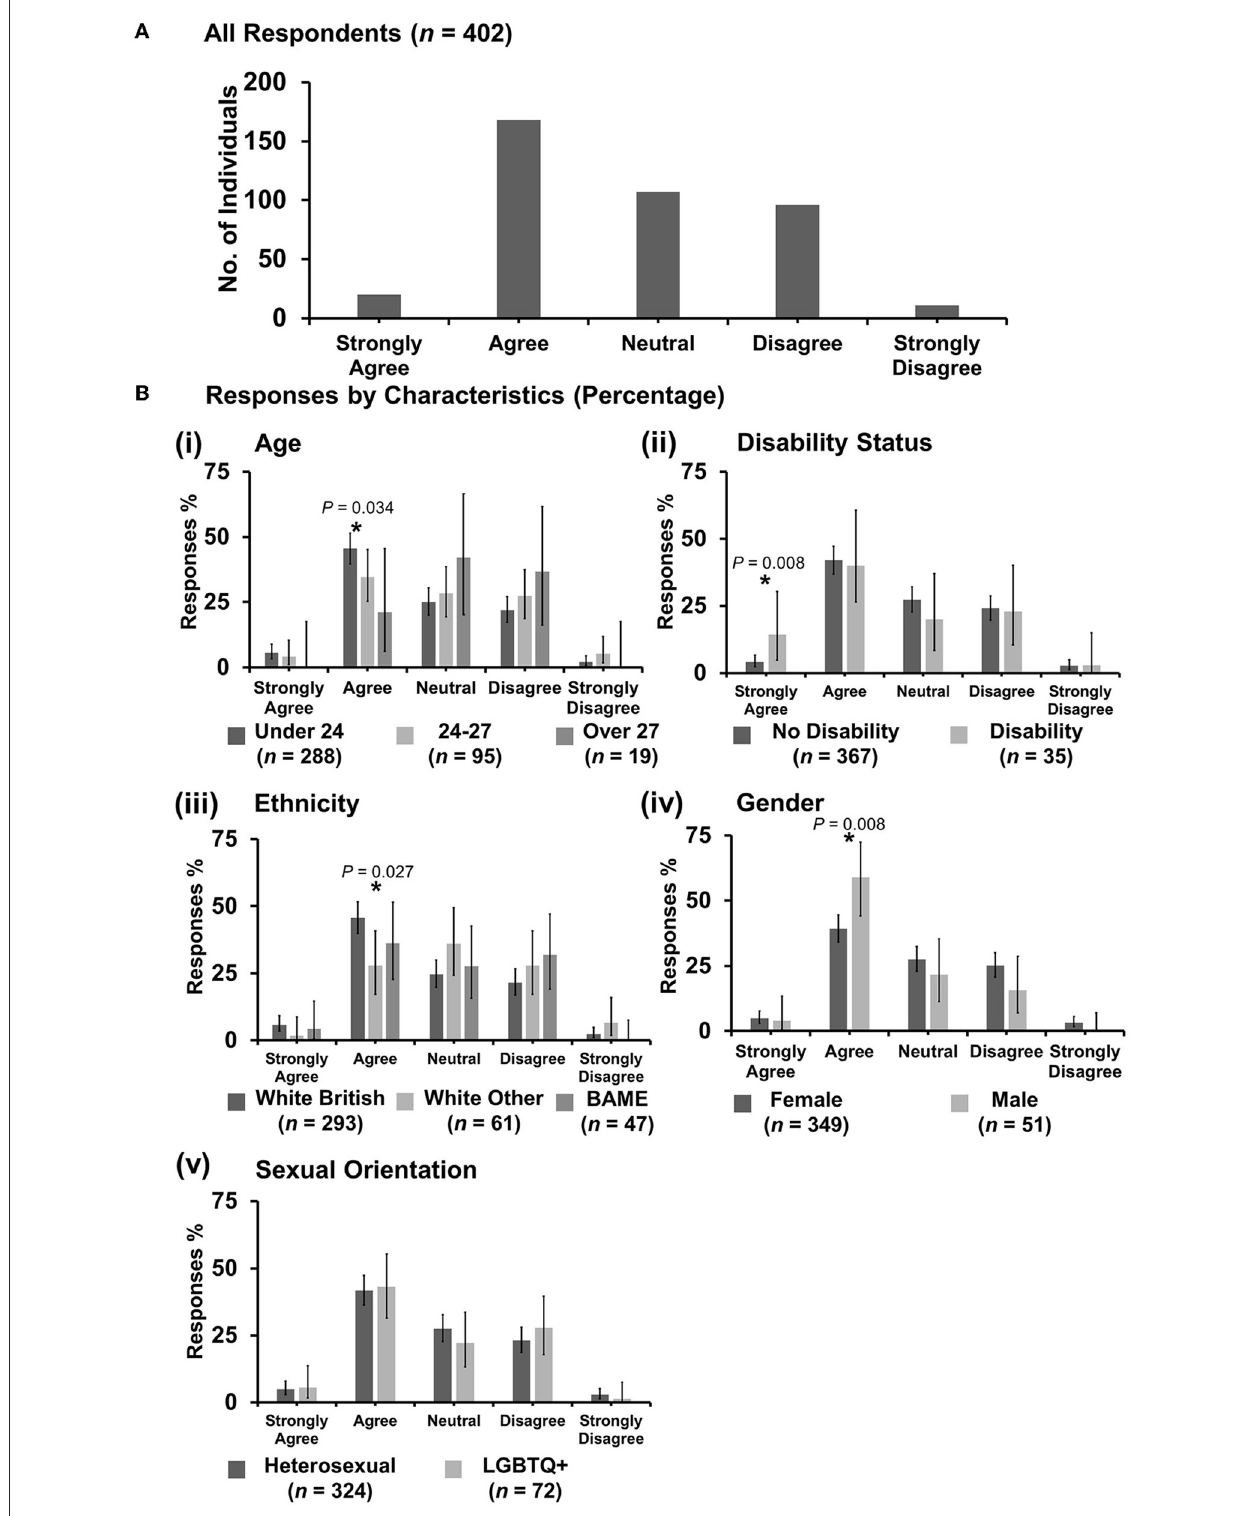
FIGURE10 Likert scale selections for the statement: older veterinary students are discriminated against less. (A) Bar graph demonstrating the number of respondents selecting each Likert scale response. [ (B) i–v] Bar graphs demonstrating by percentage proportion the number of responses in each Likert category by the group under the demographic categories of age, disability status, ethnicity, gender, and sexual orientation. Error bars represent 95% confidence intervals calculated by the Binomial “Exact” method. Statistical significance was determined by Pearson’s chi-squared test of association between respondent’s group under category and Likert scale selection. * P <